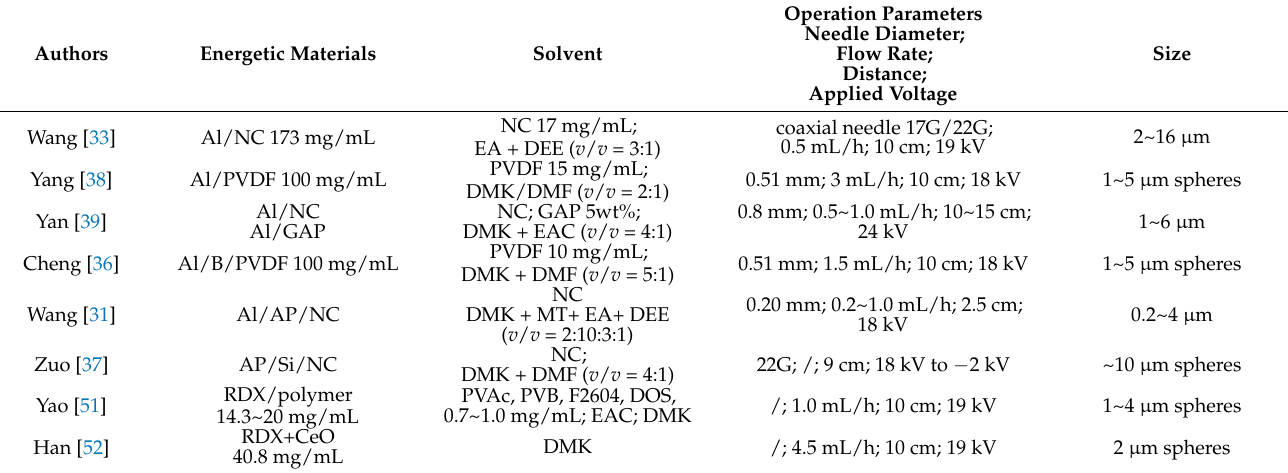
Table 2. Summary of energetic composites prepared by